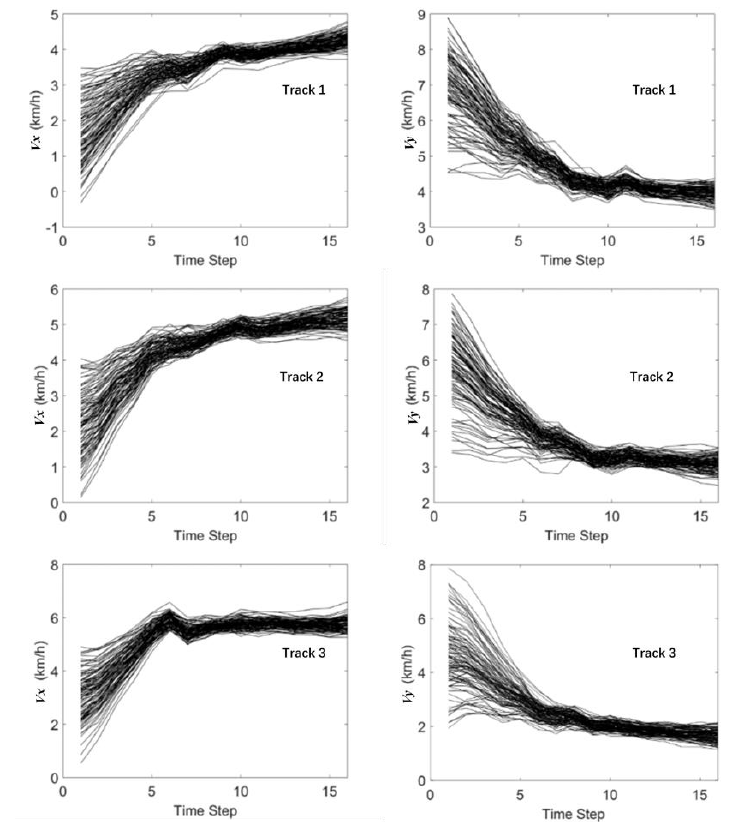
Figure 14. The history matching results of the velocity in the X-direction and Y-direction through the MHT-EnKF.